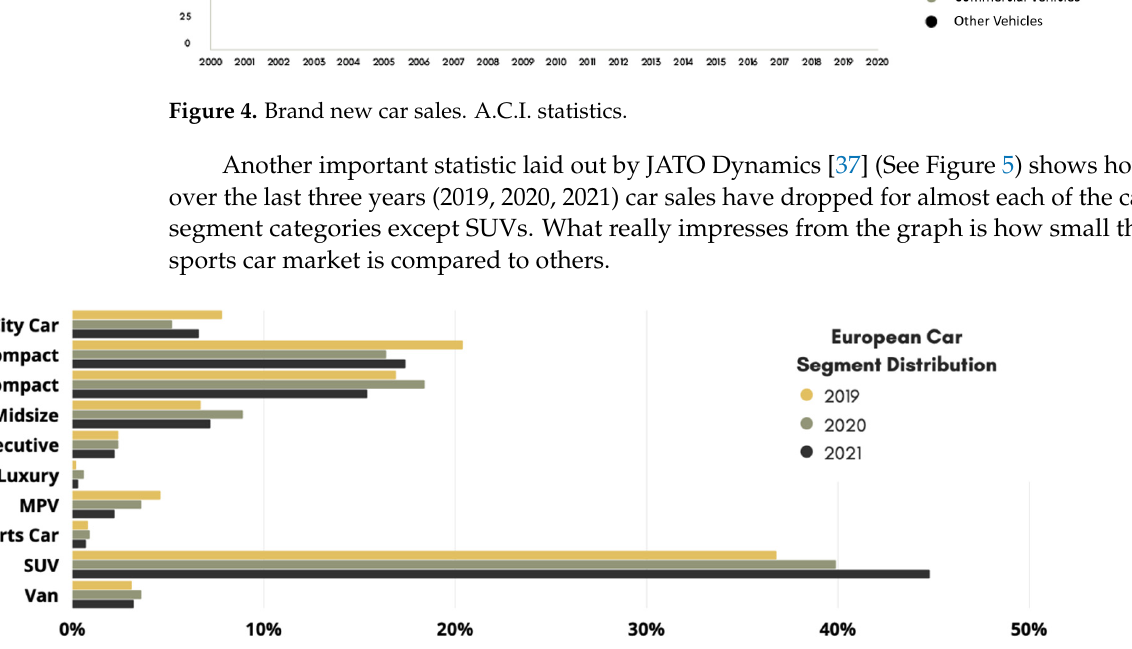
Figure 5. Car segments sales trends in Europe, JATO statistics.